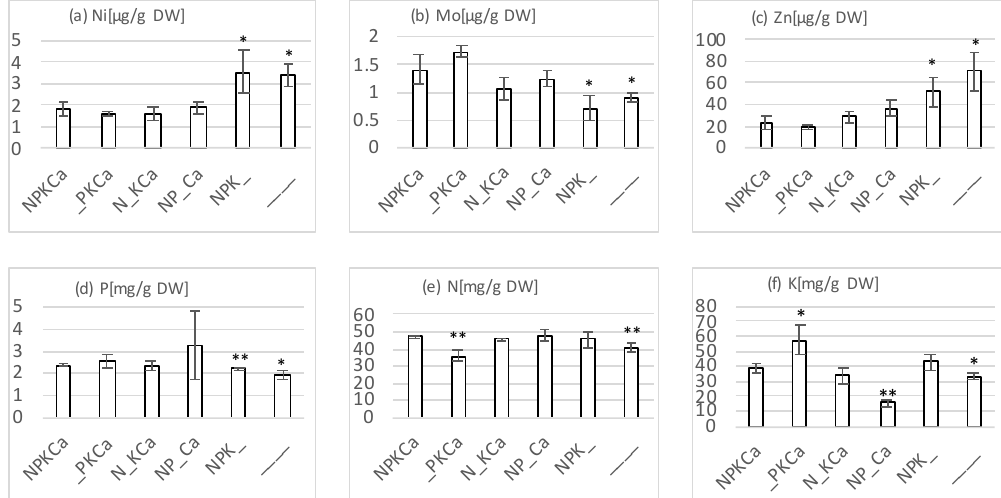
Figure 3. Nutrient contents of young sugar beet leaf blades at the LTFE Dikopshof Wesseling harvested on 26 August 2019. Three young leaves from different plants grown under fertilization treatments as indicated were dried for seven days at 60 ◦ C. Approximately 7 mg of ground plant material was subjected to N determination by an elemental analyzer while approximately 500 mg were digested by nitric acid and then subjected to either K-determination by flame photometry or ICP-OES measurements (Ni, Mo, Zn, and P). Error bars indicate standard deviation. Each treatment was tested against the NPKCa-treatment using an unpaired, two-sided t-Test (n = 3). Significance is indicated as * for p = 0.05 and ** for p = 0.01.